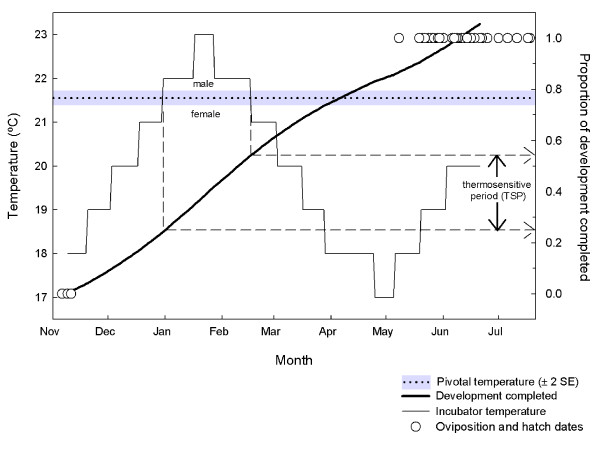
Development of S. guntheri embryos under a temperature regime designed to mimic the natural incubation environment. These experiments, conducted in three successive years (1989–1991), always produced males. The proportion of development completed (heavy line) was estimated from development rates at constant temperatures adjusted to set incubator temperatures using Q10 for S. guntheri, and a Q10 for S. punctatus for temperatures below 18°C (Table 2). Because incubator temperatures only exceeded the pivotal temperature (21.57°C) over a single developmental window, we infer that the TSP for tuatara occurs wholly or partially within 0.25 and 0.55 of development.